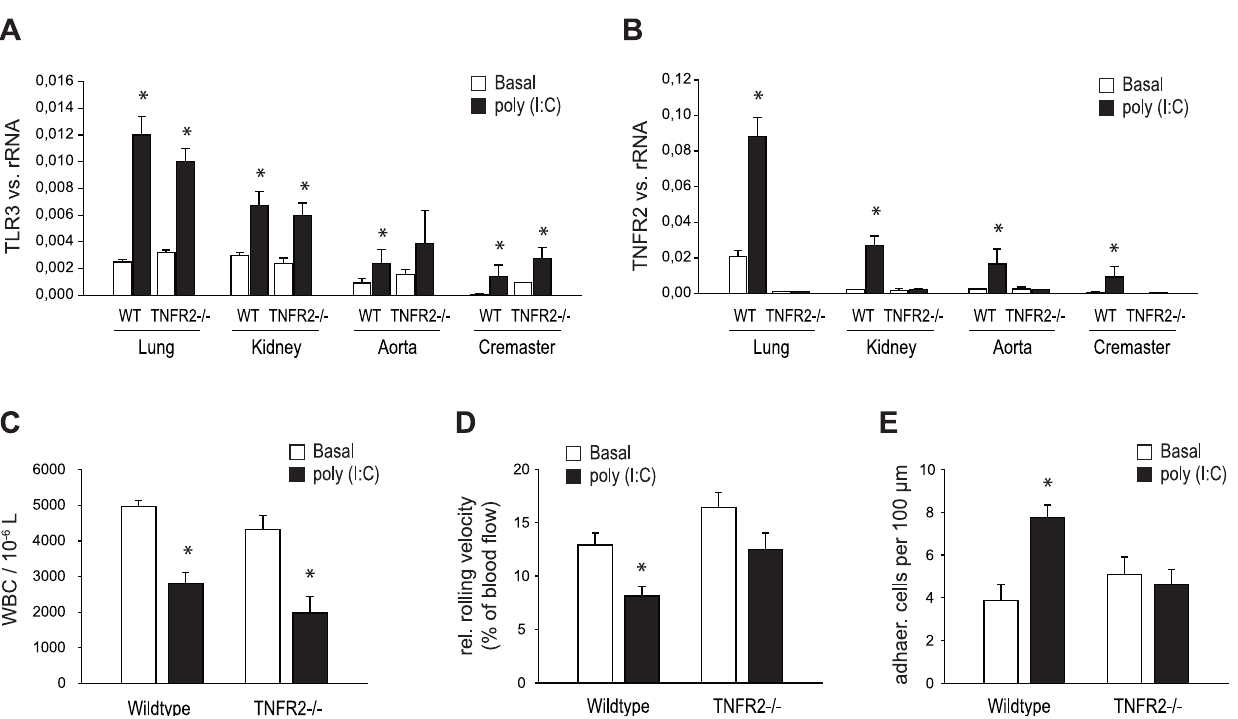
Figure 6. Role of TNFR2 in poly (I:C) induced vascular inflammation. WTand TNFR2 -/- mice were sham treated or treated with poly (I:C) 200 m g i.p. as described and expression of TLR3 and TNFR2 was analyzed by RT-PCR. Expression of TLR3 (A) and TNFR2 (B) was measured in lung, kidney, aorta and cremaster muscle tissue after 48 hours. At the same time point white blood cell counts were performed and effects of poly (I:C) on trauma-induced leukocyte rolling and adherence in vivo were investigated in cremaster muscle venules by intravital microscopy (C–E). Statistically significant differences to the control are depicted with * 5 p #